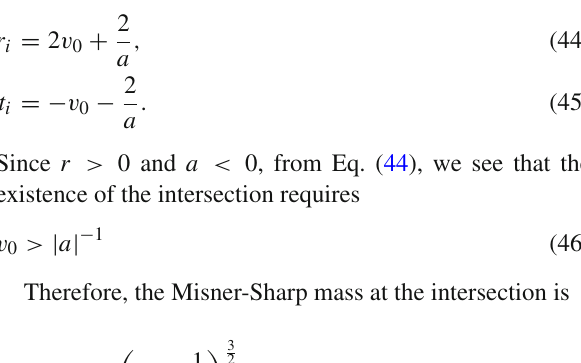
Fig. 2 PenrosediagramfortheHMNspacetime( a (cid:4)= 0 , c = 0)match- ing with an outging Vaidya spacetime at v = v 0 . The singularity is located at t = − a −